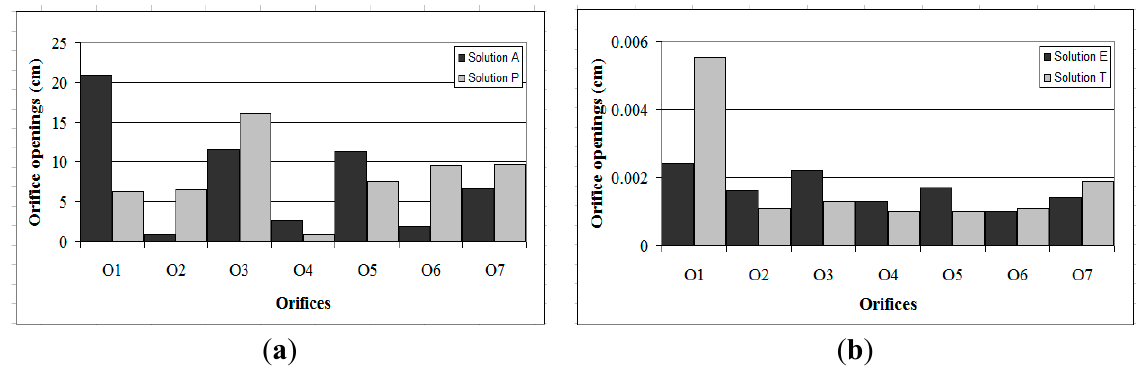
Figure 6. Orifice openings for optimal solutions. ( a ) Minimum pollution load case; ( b ) Minimum treatment cost case.